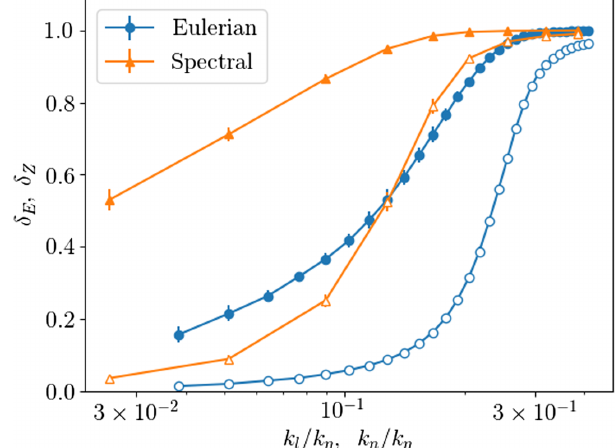
FIG. 9. Values of the velocity correlations δ E (filled symbols) and the vorticity correlations δ Z (empty symbols) as a function of the maximum nudged wave number k n (spectral case) or the mean nudged wavelength k l (Eulerian